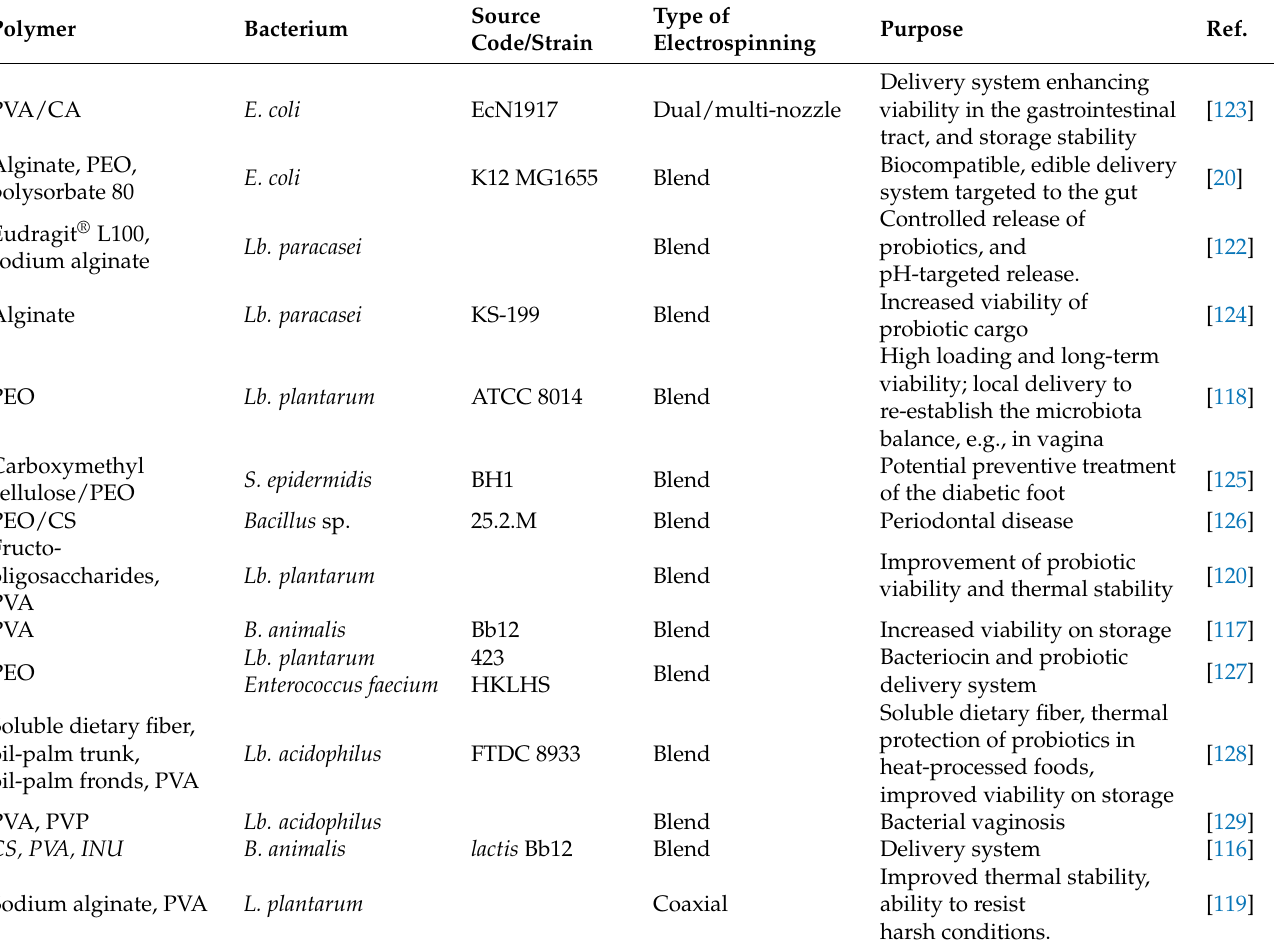
Table 4. A list of probiotics that have been incorporated into electrospun nanofibers, along with the potential applications.